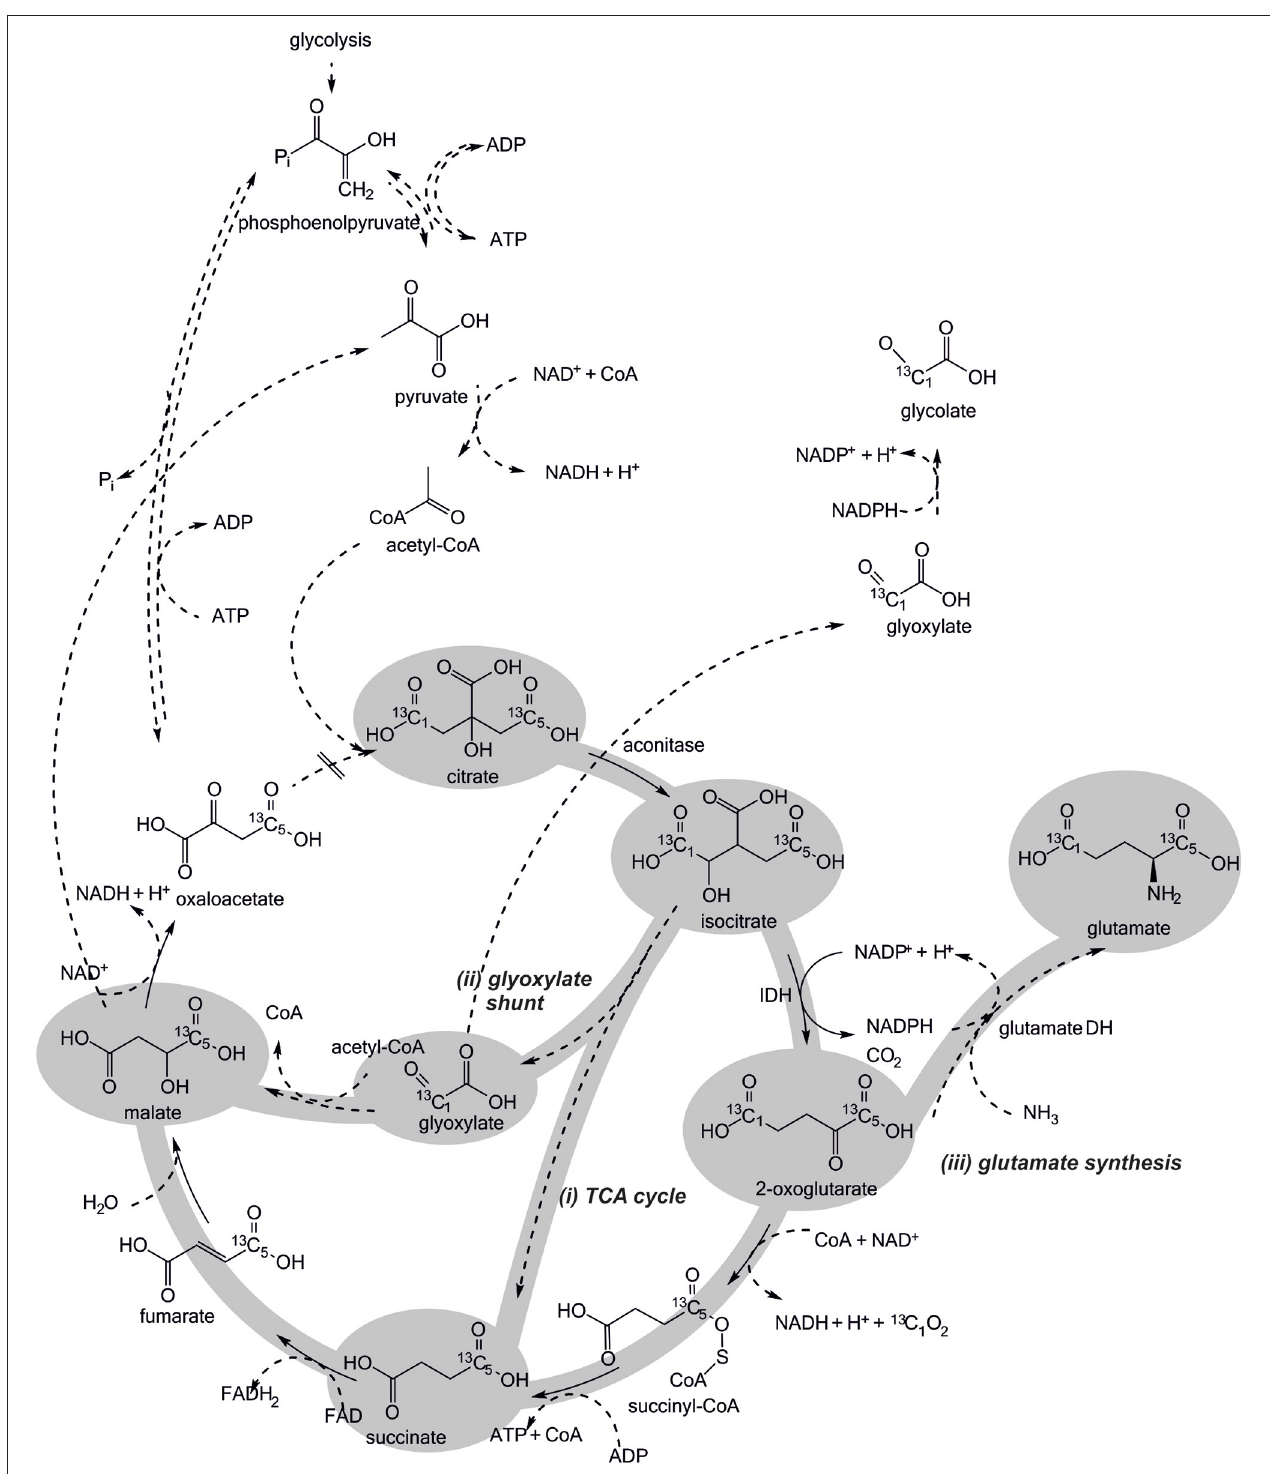
FIGURE 5 | Potential routes of citrate metabolism in Escherichia coli BL21 crude cell extract. The 13 C-labeling introduced via citrate is distributed among the depicted intermediates, depending on which enzymes are active under CCE conditions. All four routes contribute differently to NADPH regeneration. The first step of the TCA cycle, the condensation of oxaloacetate and acetyl-CoA to citrate is presumably not active in CCE.